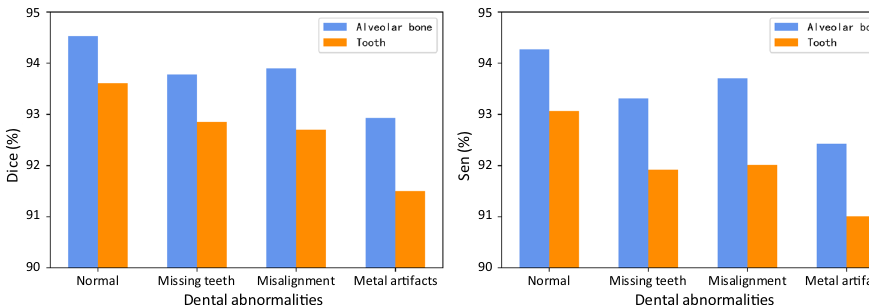
Fig. 3 Segmentation performance of the CBCT scans with different dental abnormalities, including the Dice and the